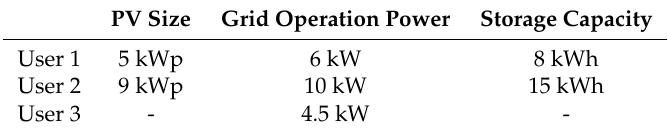
Table 1. Local PV, grid connection, and storage systems for the three